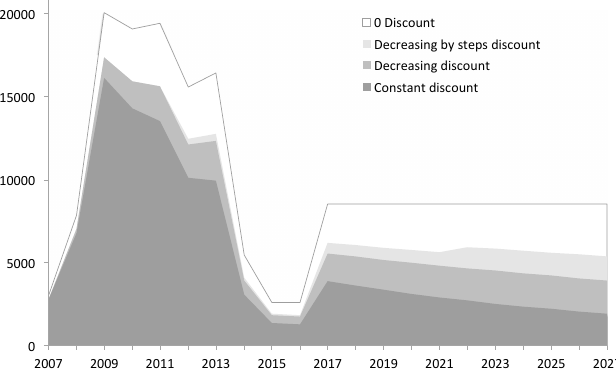
Figure 13. Scenarios of the Net Present Values (the white and grey surfaces) of the imputed expenditure cash flow according to different hypotheses of inter-generational solidarity (y-axis: 000EUR).